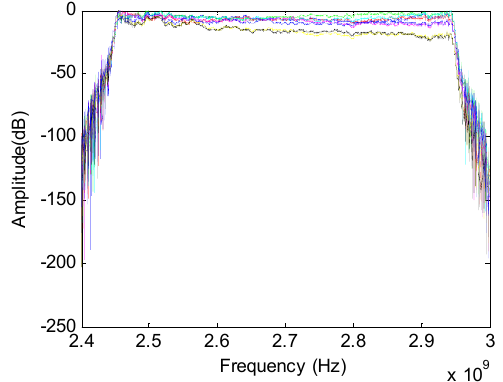
Figure 18. Received signals expressed in frequency domain.